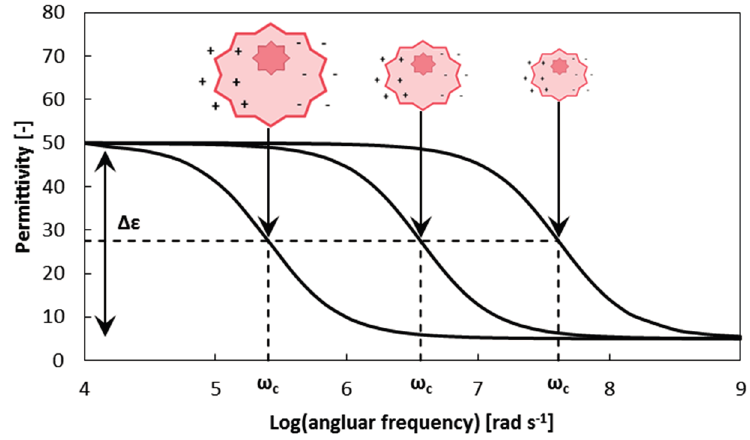
Figure 6. The polarisation of a cell at a given electrical frequency is dependent on cell